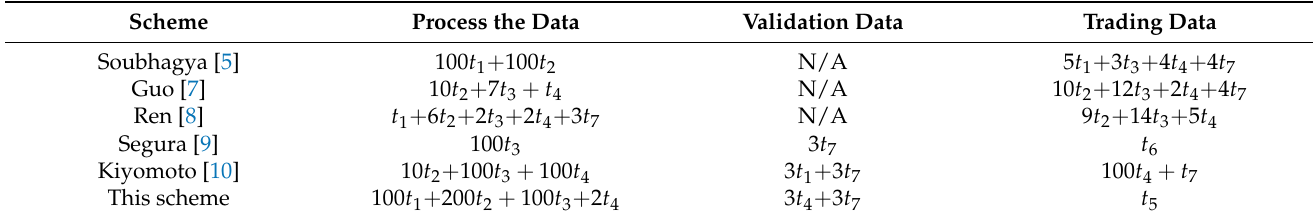
Table 2. Scheme efficiency.